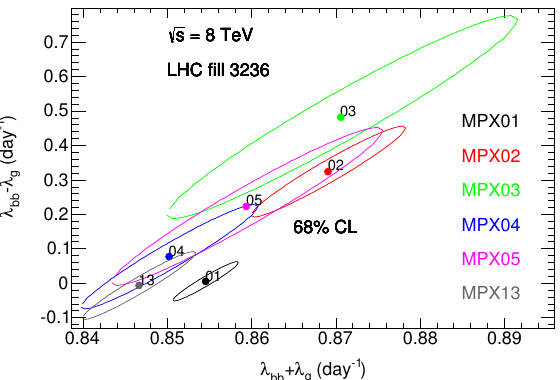
Figure 19. Contour curves of ( λ bb − λ g ) and ( λ bb + λ g ) , given at 68% CL, for the fit results of the average number of interactions per bunch crossing as a function of time seen by MPX01-05 and MPX13. The dots in the center of the contours indicate the fit values. The hit statistical uncertainties and systematic uncertainties from luminosity fluctuations not described by the fit function are added in quadrature, given in Table 9, and then scaled to yield χ 2 /ndf = 1. LHC fill 3236. Taken from Ref. [11]. The analysis performed with LHC fill 3236 data has been repeated with LHC fill 3249 data, taken 31 October to 1 November 2012, for µ = 13.4 to µ = 9.8. The MPX01 results from LHC fill 3249 lead to a relative precision below RMS 0.3% (Figure 20) in agreement with the results from LHC fill 3236. Table 10 gives the relative statistical uncertainties and lists the total uncertainties for RMS 0.2% (obtained in LHC fill 3249) and RMS 0.3% (obtained for LHC fill 3236). The corresponding pull values for statistical and total uncertainties are given in Table 11.